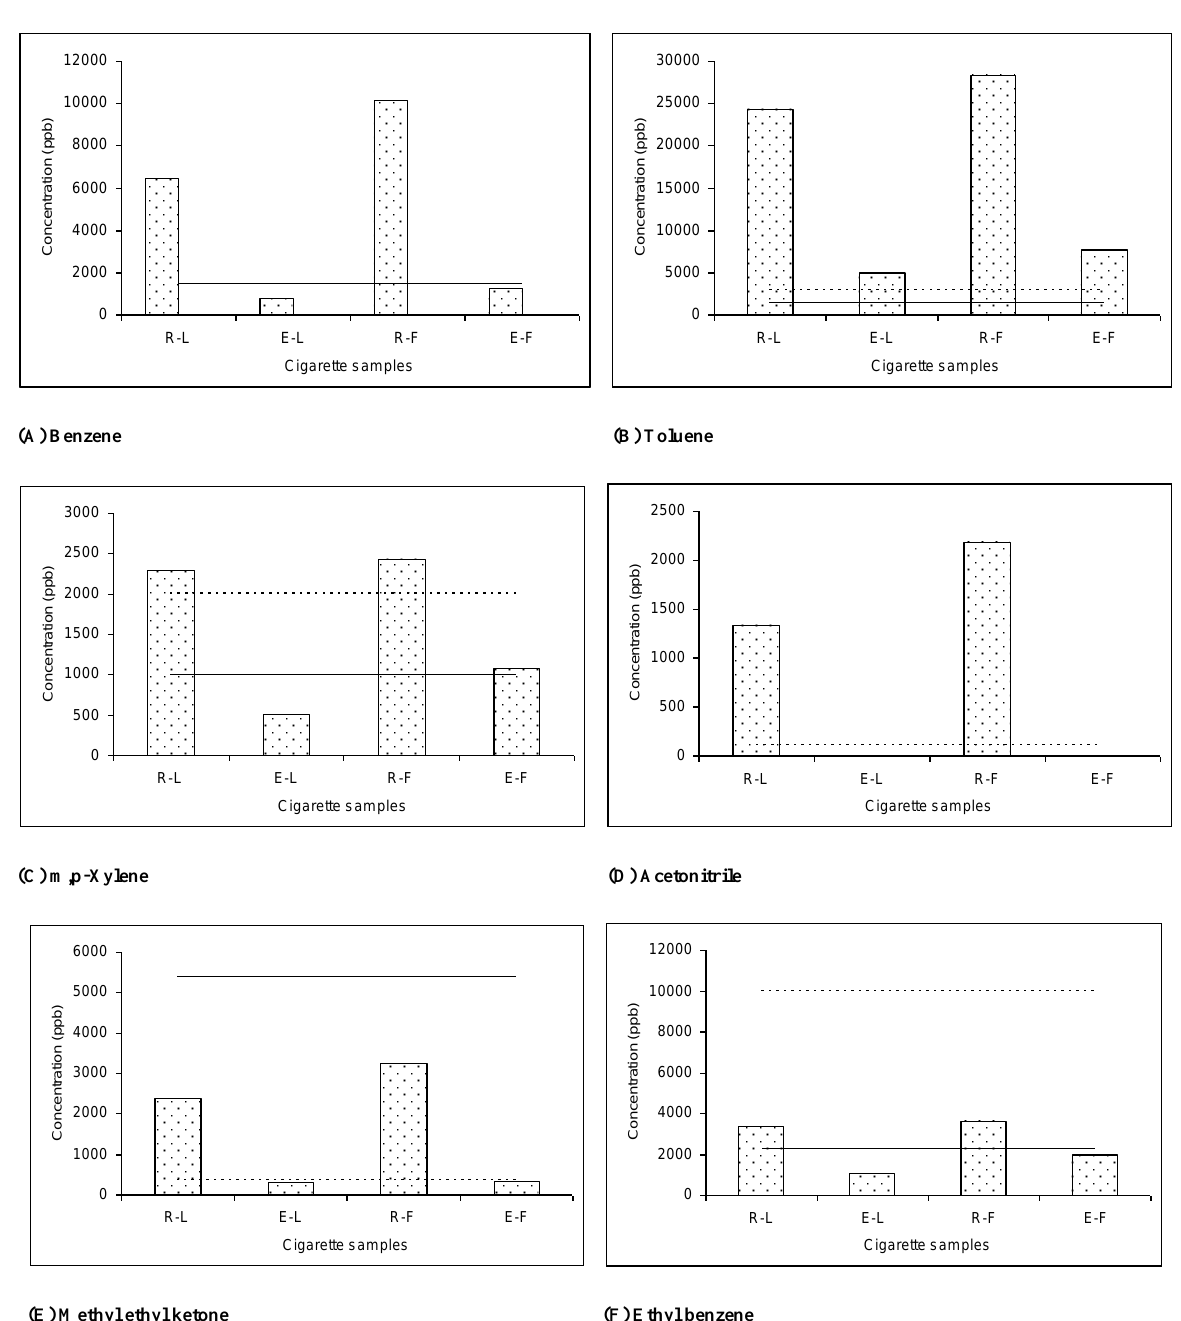
FIGURE 1. Comparison of concentration levels of HAPs (listed by the U.S. EPA) detected in different MSS samples with the exposure limits and odor threshold values prescribed by various agencies: (1) acute minimum risk levels (MRLs) by ATSDR for benzene, toluene, m-p-xylenes, acetonitrile, ethyl benzene, and styrene; (2) REL of NIOSH for acetaldehyde and phenol; and (3) reference concentration (RFc) of MEK by the U.S. EPA. Dotted lines show the exposure limits prescribed by various agencies and straight lines show the odor threshold values given by various agencies (i.e., benzene, toluene, methyl ethyl ketone, and styrene by the U.S. EPA and m-p-xylene by OSHA). Continued next